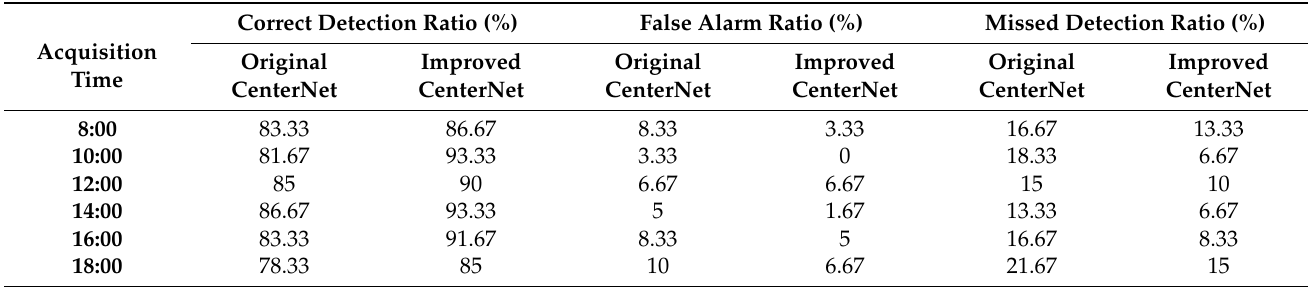
Table 2. Comparison of leaf detection accuracy for images acquired at different outdoor time periods. 50 images were collected for each time period, each image contains 60